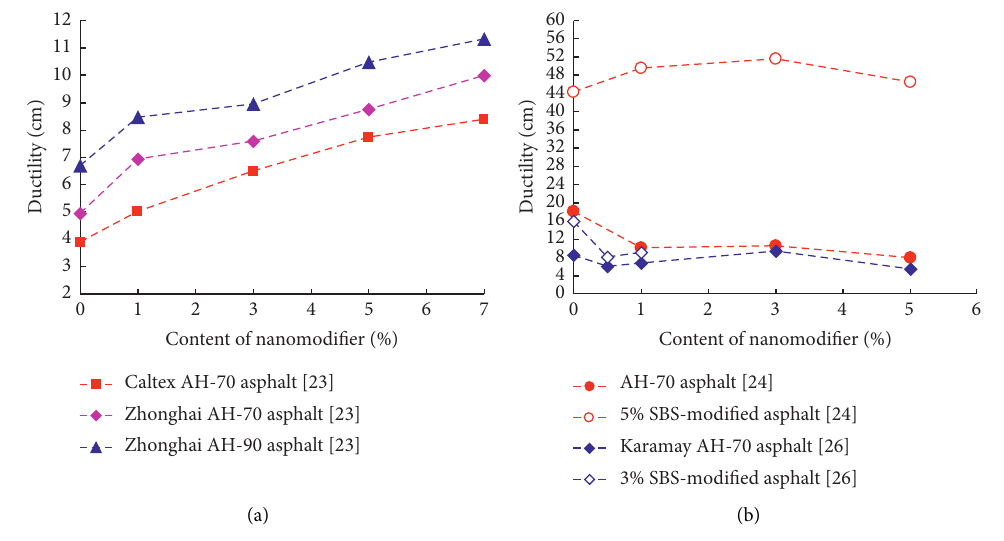
Figure 1: Softening point of different asphalt.